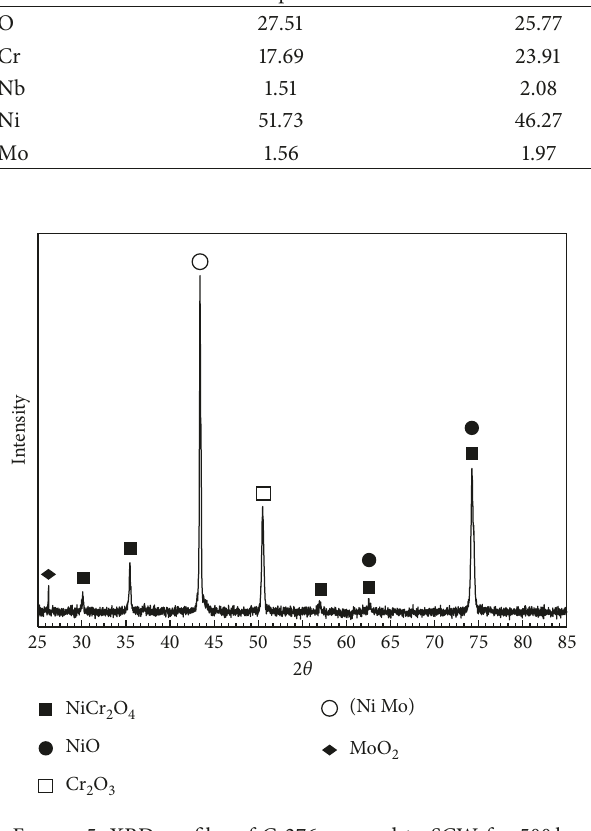
Figure 5: XRD profiles of C-276 exposed to SCW for 500h.